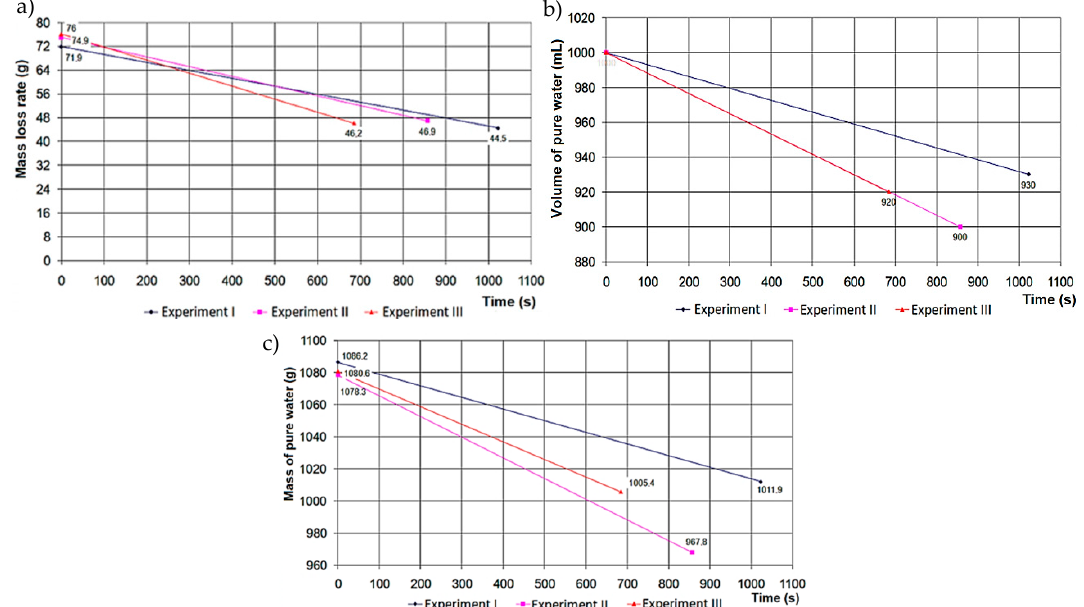
Figure 12. The changes of the mass ( c ) and volume of pure water ( b ) supplied to the gasification reactor and the mass loss rate ( a ) of the coal sample from hard coal mine A.